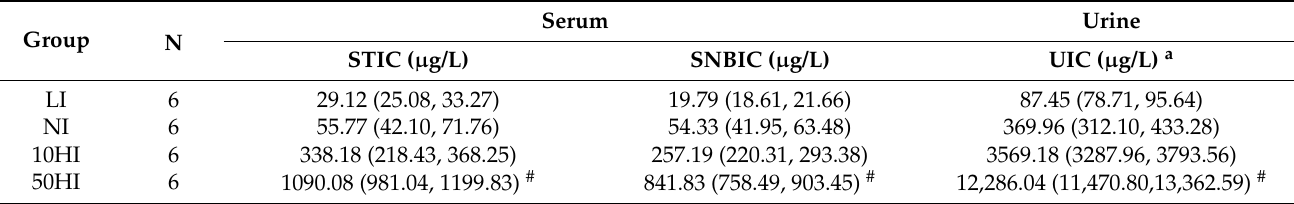
Table 1. Serum iodine and spot urine iodine concentration of lactating rats.